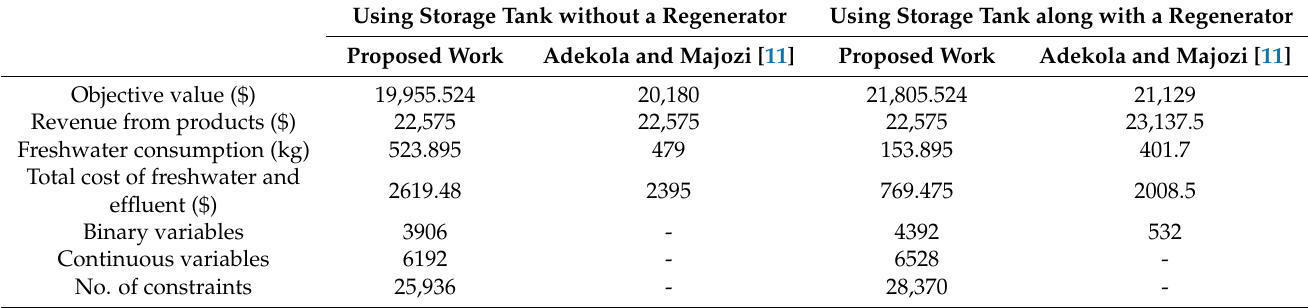
Table 4. Comparison of results for case study